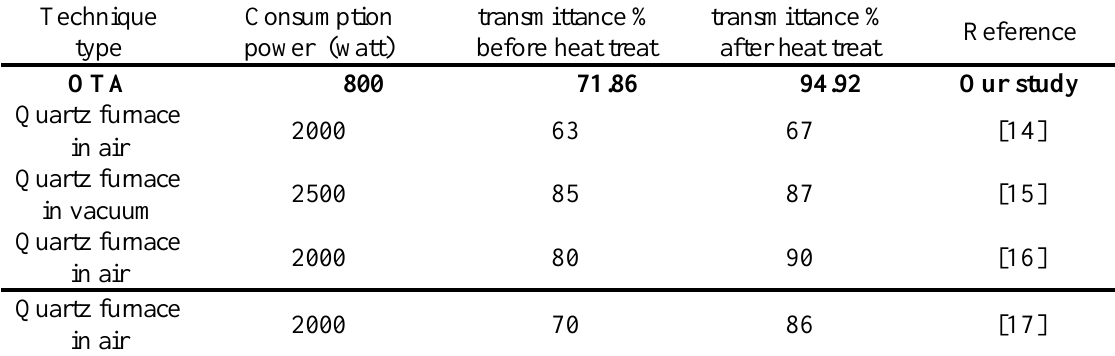
Table 4. Show the transparency of the ZnO thin film before and after treatment by OTA processes at 300 ⁰C compared with those of other